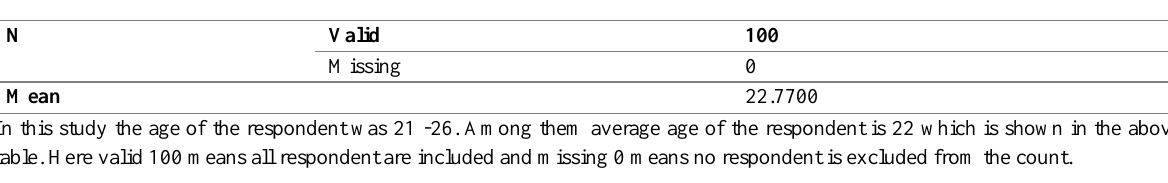
Table 2: Age of the participants